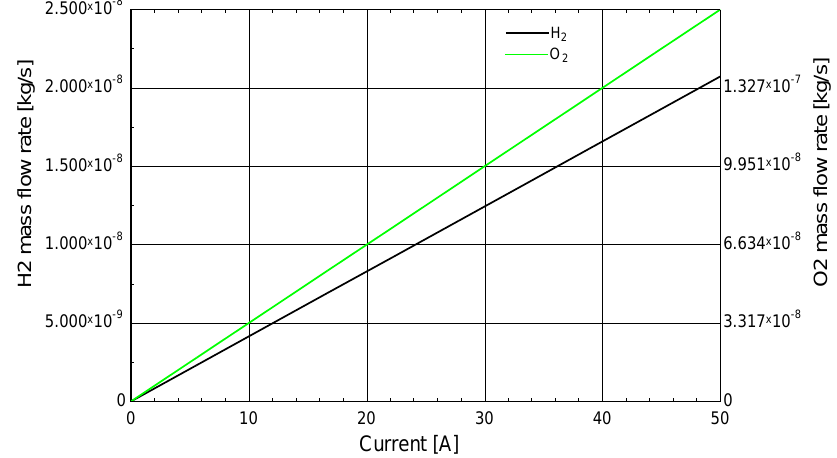
Figure 14. Effect of current on the mass flow rate of hydrogen.